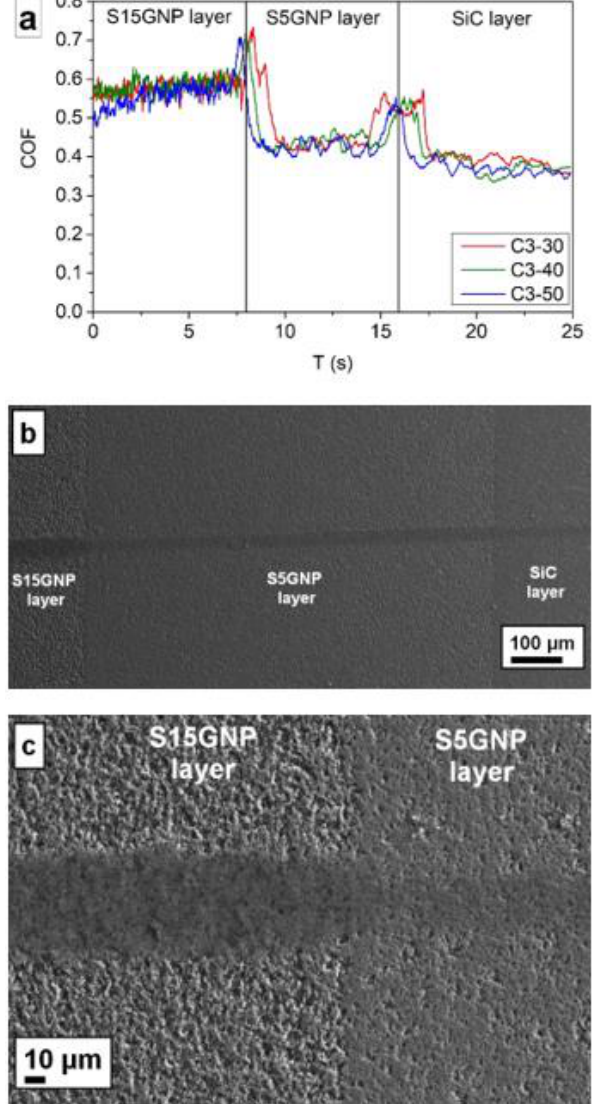
Figure 5. Scratch tests of 3-layered composites C3-x (where x = 30, 40, 50), ( a ) coefficient of friction of 3-layered composites measured by scratch tests ( b ) macrostructure with visible scratch after test and ( c ) detail of the scratch between two layers in C3-50 sample.